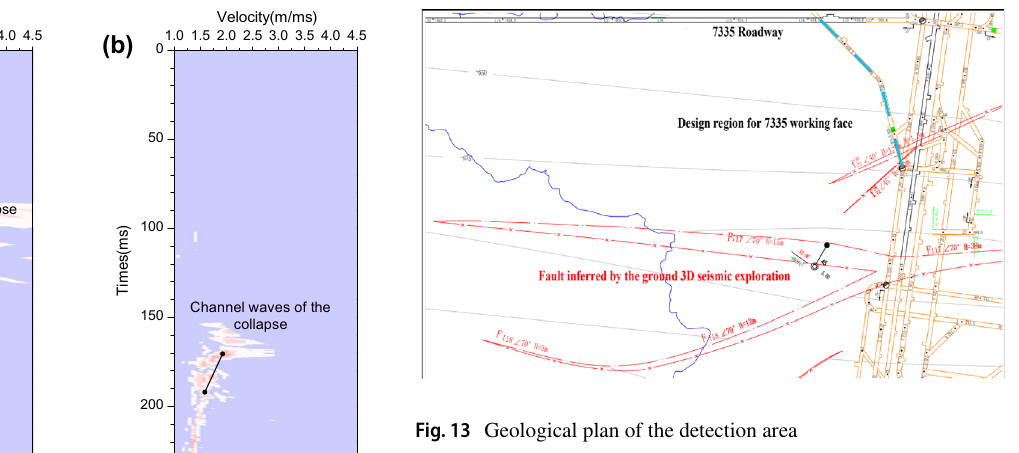
Fig. 13 Geological plan of the detection